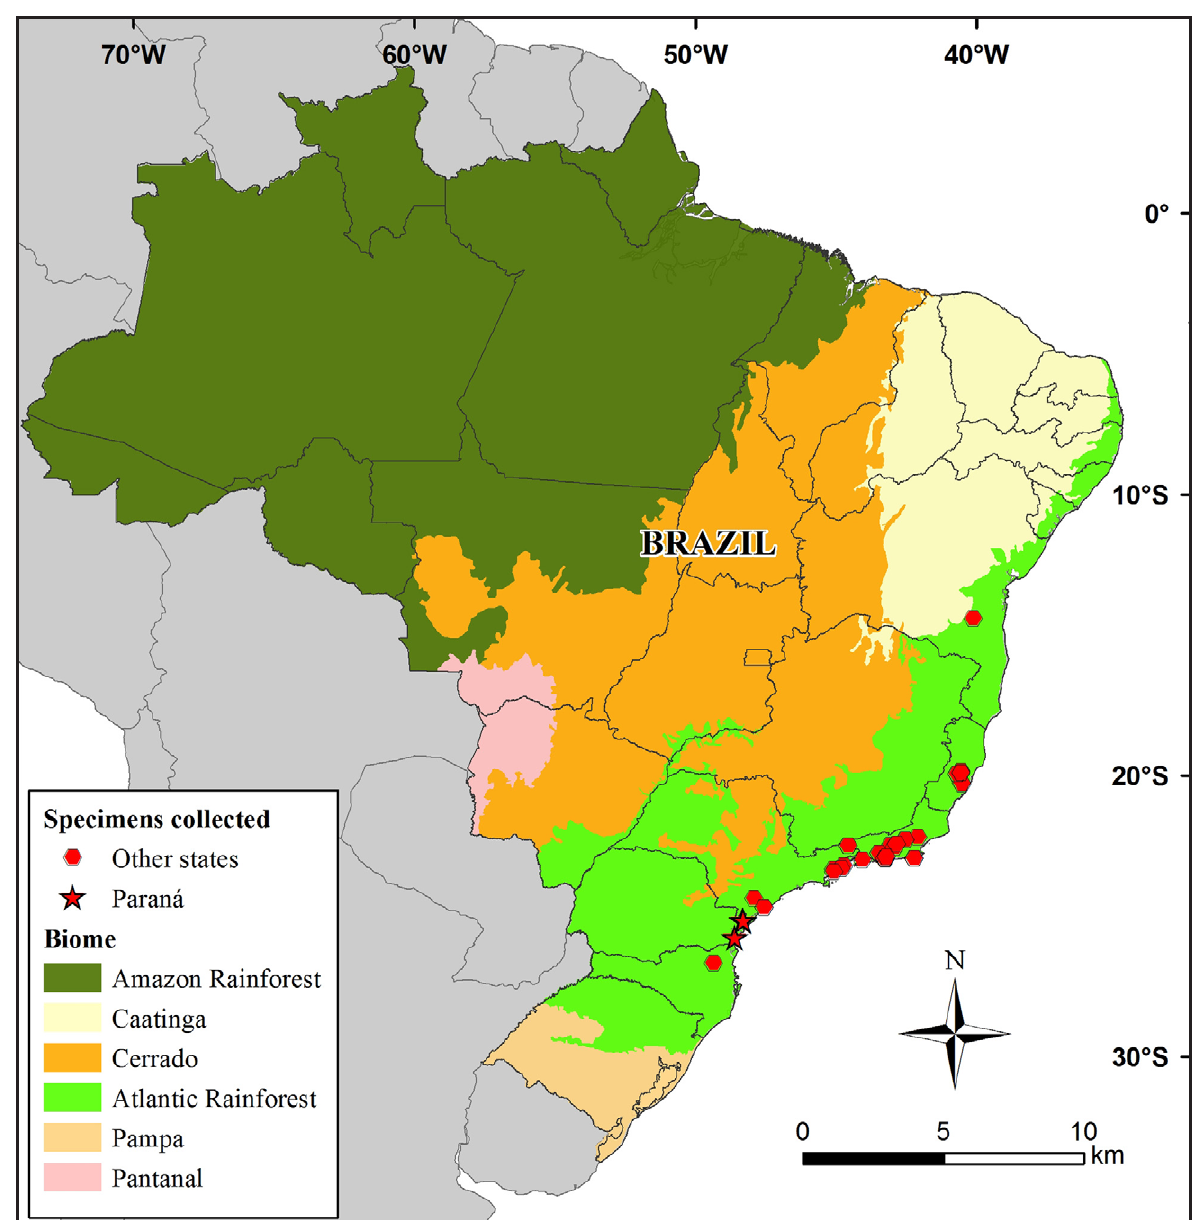
Figure 6. Distribution of Henriettea glabra (Vell.) Penneys, Michelang., Judd et